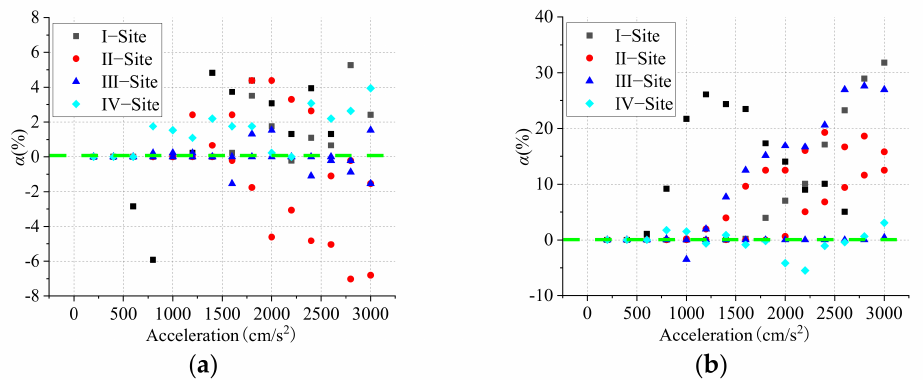
Figure 11. Values of γ and the seismic amplitude for the shell with each roofing system: ( a ) bolted purlin roofing system; ( b ) welded purlin roofing system.